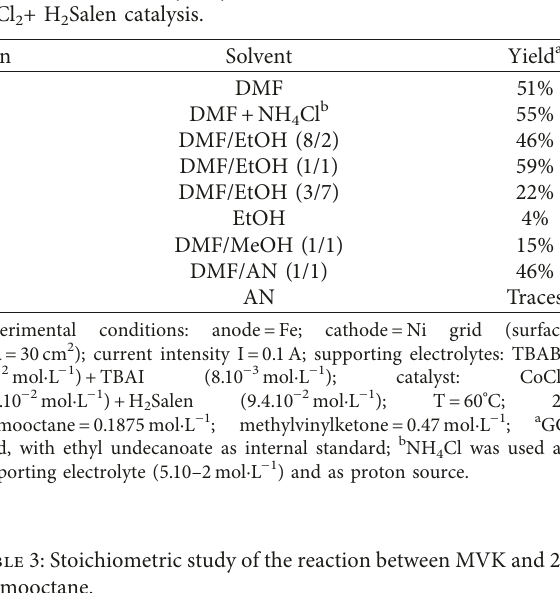
Table 2: Results of the reductive coupling reaction of 2-bro- mooctane with methylvinylketone in various solvents under CoCl 2 + H 2 Salen catalysis.